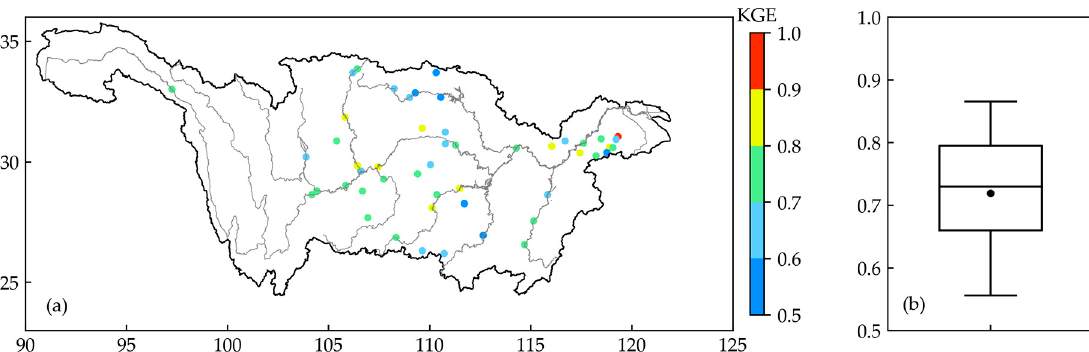
Figure 3. ( a ) Spatial distribution of KGE between observed and CSSPv2 model-simulated monthly streamflow over the Yangtze River basin. ( b ) The boxplot of KGE for all 49 stations. The boxes represent the 25th and 75th percentiles of KGE, the line and the dot within the box are median and mean values of KGE, respectively, and the whiskers represent 10th and 90th percentiles of KGE.